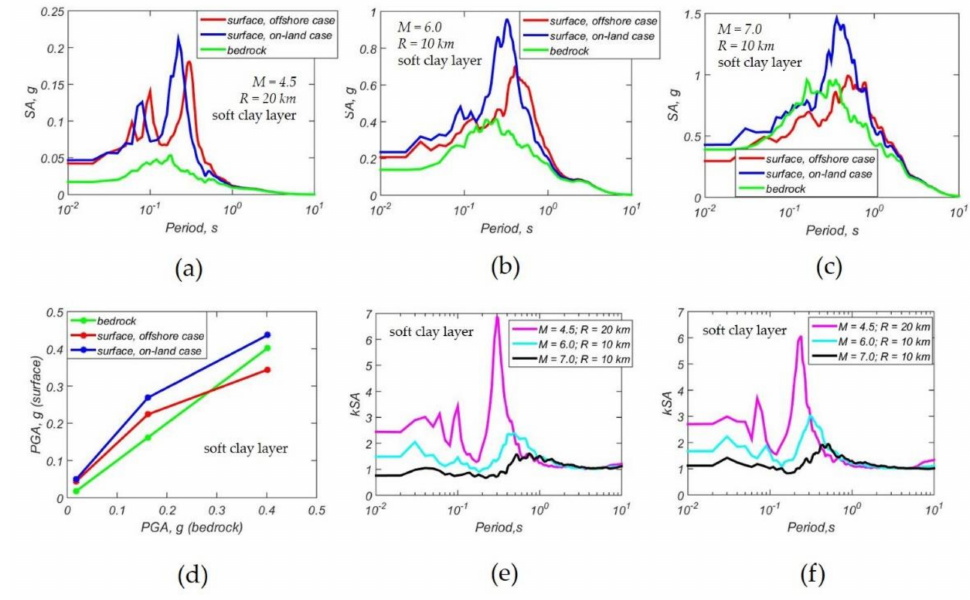
Figure 12. Modeling results for the case of soft clay layer: ( a – c ) response spectral acceleration SA ( T , 5% ); ( d ) PGA values; ( e ) acceleration amplification curves for offshore case; ( f ) acceleration amplification curves for the onshore